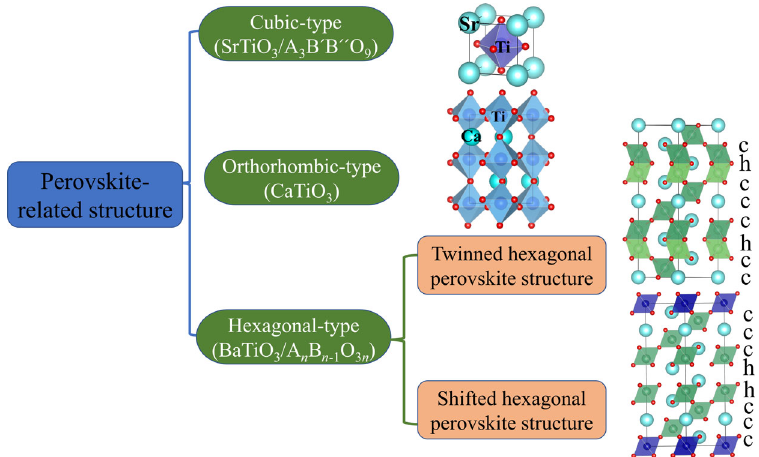
Fig. 17 Classification and the representative structure of perovskite-related structure.